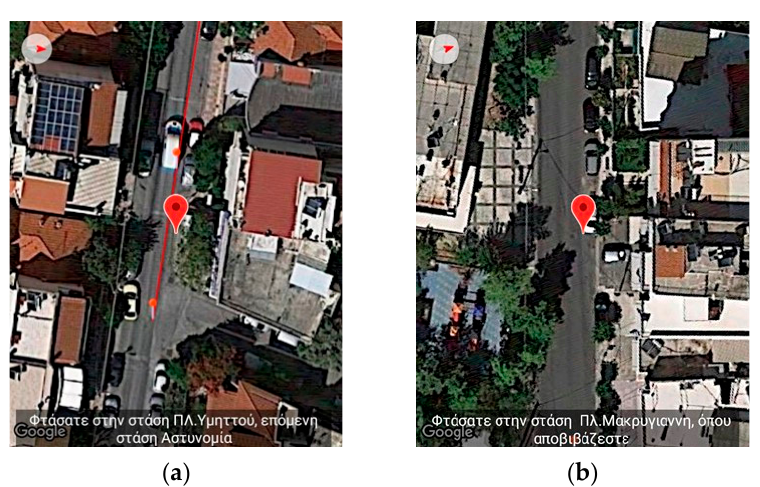
Figure 11. Application’s Training version—Snapshot from simulating pedestrian navigation com- bined with public transportation. ( a ) depicts the message when reaching and passing intermediate bus stops “You reached Ymittos square stop. Next stop Police” while ( b ) displays the message “You reached Makrigianni square stop. You exit here”.